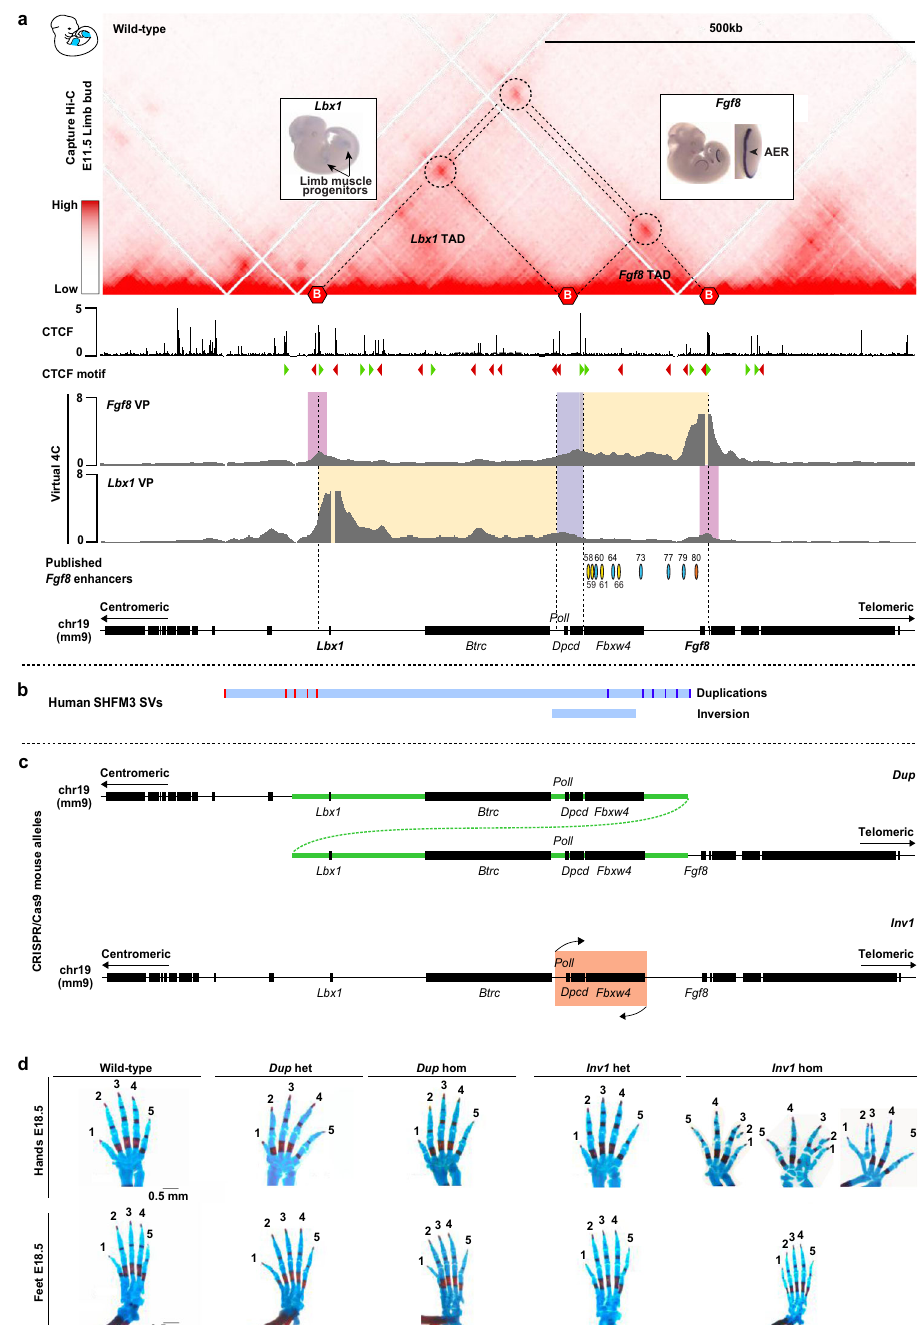
Fig. 1 | Engineering of the SHFM-associated structural variations at the Lbx1 / Fgf8 locus.a cHi-C (data are shown asmerged signalof n =3 biological and 1 technical replicates) of extended Lbx1 / Fgf8 locus generated from wild-type E11.5 mouse limb buds. Lbx1 and Fgf8 are located within distinct TADs (indicated by single dashed lines) separated by boundaries (indicated by red hexagons) in cor- relation with CTCF binding sites, as indicated in ChIP-seq from E11.5 mouse limb buds 61 below. Loops (dashed circles) indicate interaction between CTCF sites. Interaction plots using virtual 4C from Fgf 8 and Lbx1 viewpoints (VP) are shown below. Regions of interactions relative to Lbx1 and Fgf8 within their own TADs are highlighted in yellow, whereas contacts with the boundary region between Lbx1 and Fgf8 TADs and those over such boundary are in violet and pink, respectively. Published Fgf8 enhancers 28 areindicatedbyovals.Yellowovalshighlightenhancers